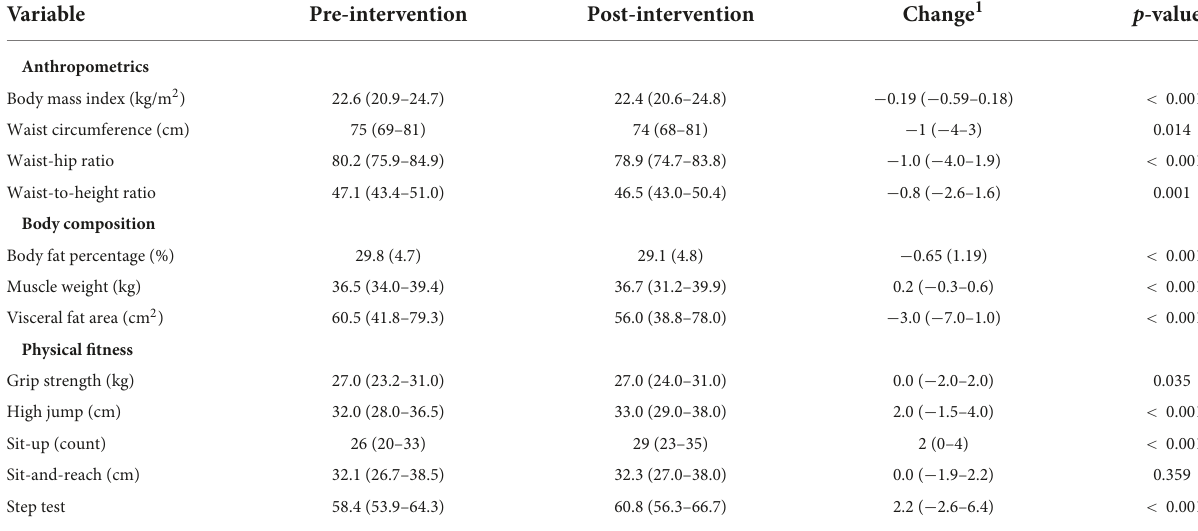
TABLE 2 Changes in outcome parameters for whole cohort ( n =